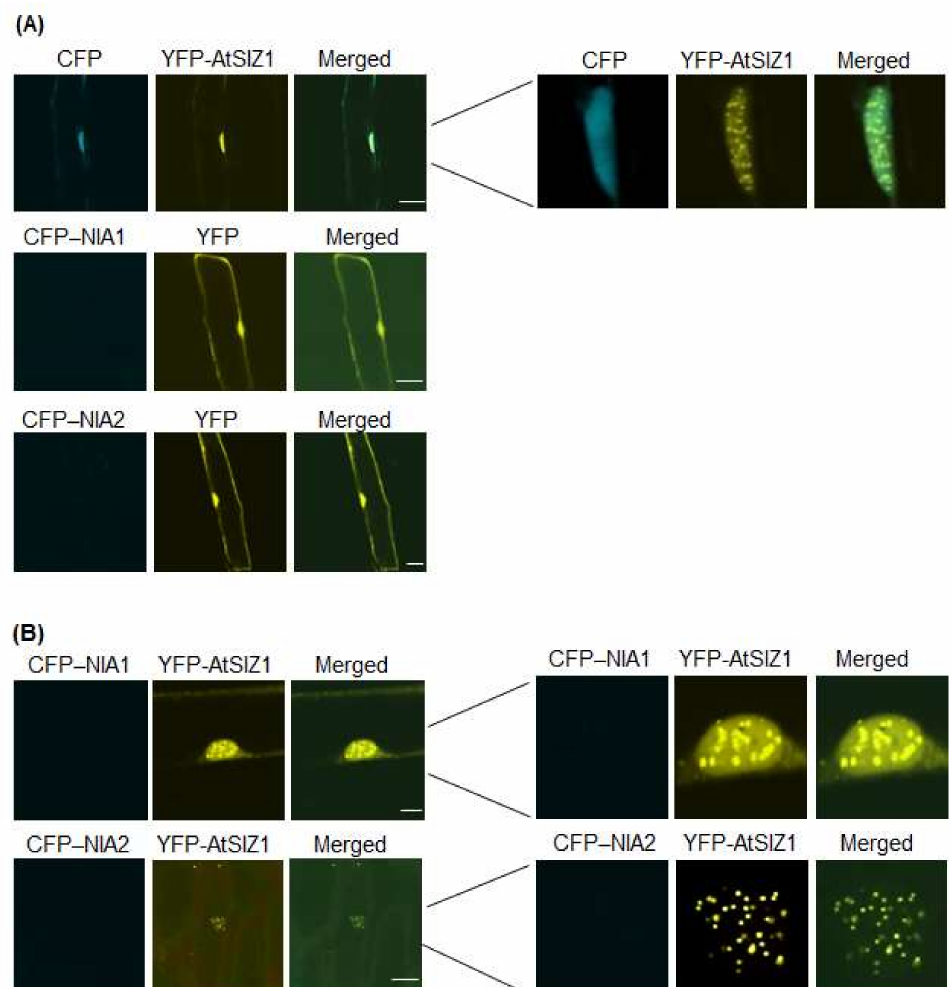
Figure 3. Effect of ammonium on subcellular localization of AtSIZ1 and NR proteins NIA1 and NIA2. Localization of NIA1, NIA2, and AtSIZ1 was investigated by particle bombardment of onion epidermal cells. Constructs harboring 35S-CFP-NIA1 , 35S-CFP-NIA2 , and 35S-YFP-AtSIZ1 were introduced into onion epidermal cells, either alone ( A ) or in combination ( B ), by particle bombardment. After incubation at 25 ◦ C in the dark for 16 h in 5 mM (NH 4 ) 2 SO 4 , bombarded tissues were analyzed by confocal microscopy to visualize transient expression. CFP-NIA1, CFP-NIA2, and YFP-AtSIZ1 refer to CFP and YFP fused to the C-terminus of NIA1, NIA2, and AtSIZ1, respectively. DIC, differential interference contrast. Bar, 50 µ